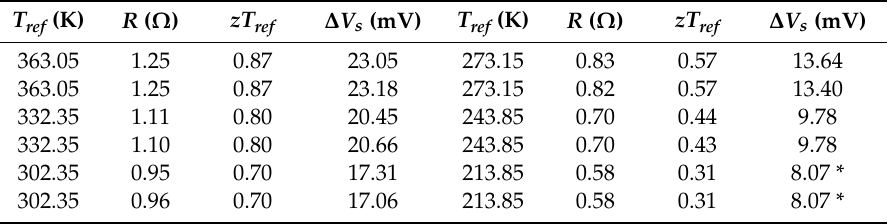
Table 6. Peltier module c: p - n series resistance, the figure of merit, and Seebeck voltage (I = 25 mA). T ref (K) R (𝛀) zT ref 𝚫 V S (mV)